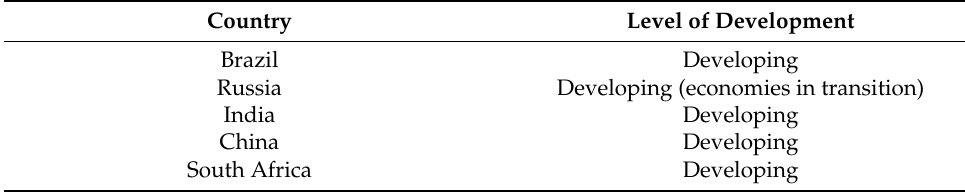
Table 1. Population of the